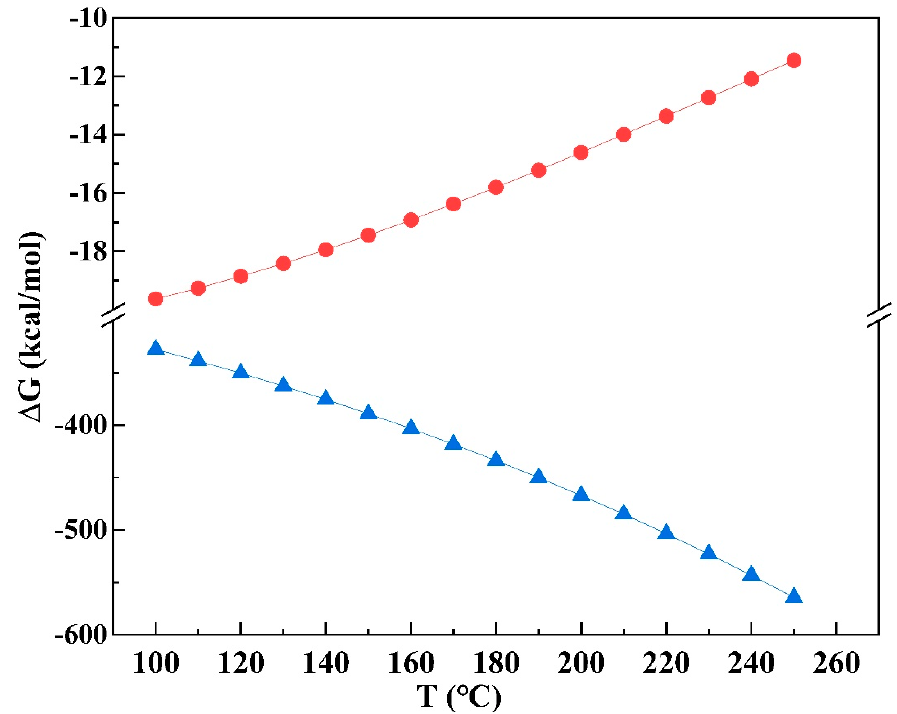
Figure 14. The Δ G θ values of Equations (9) and (10) at different temperatures. Figure 14. The ∆ G θ values of Equations (9) and (10) at different